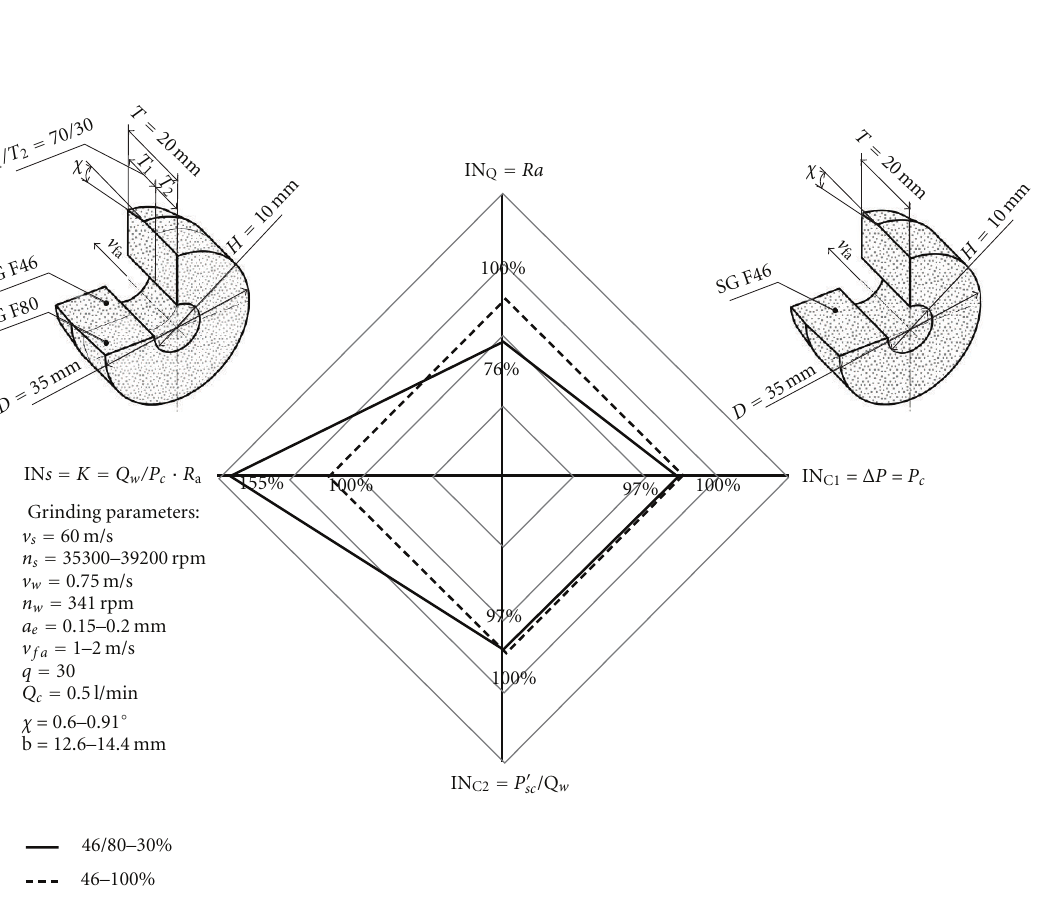
Figure 9: Percentage value setting up of the grinding e ffi ciency evaluation criteria for a grinding wheel of zone-diversified structure (46/80– 30%) with reference to a 46–100% grinding